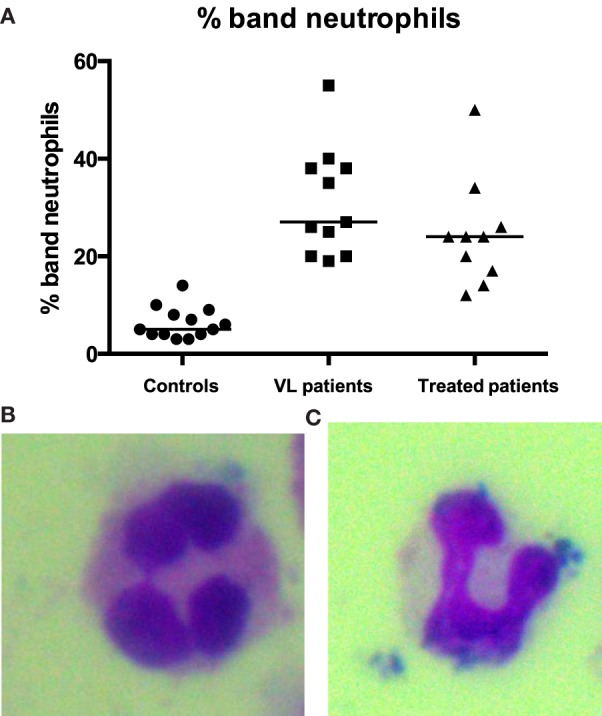
Percentages of band neutrophils. Smears from PBMCs and neutrophils purified from the blood of 13 controls, 11 VL, and 10 treated patients (=VL patients after successful treatment, with initial clinical cure) by double density gradient centrifugation were stained with Giemsa and the percentages of segmented (B) and band (A,C) neutrophils were counted per 50 neutrophils. Statistical differences were determined using a Kruskal–Wallis test.